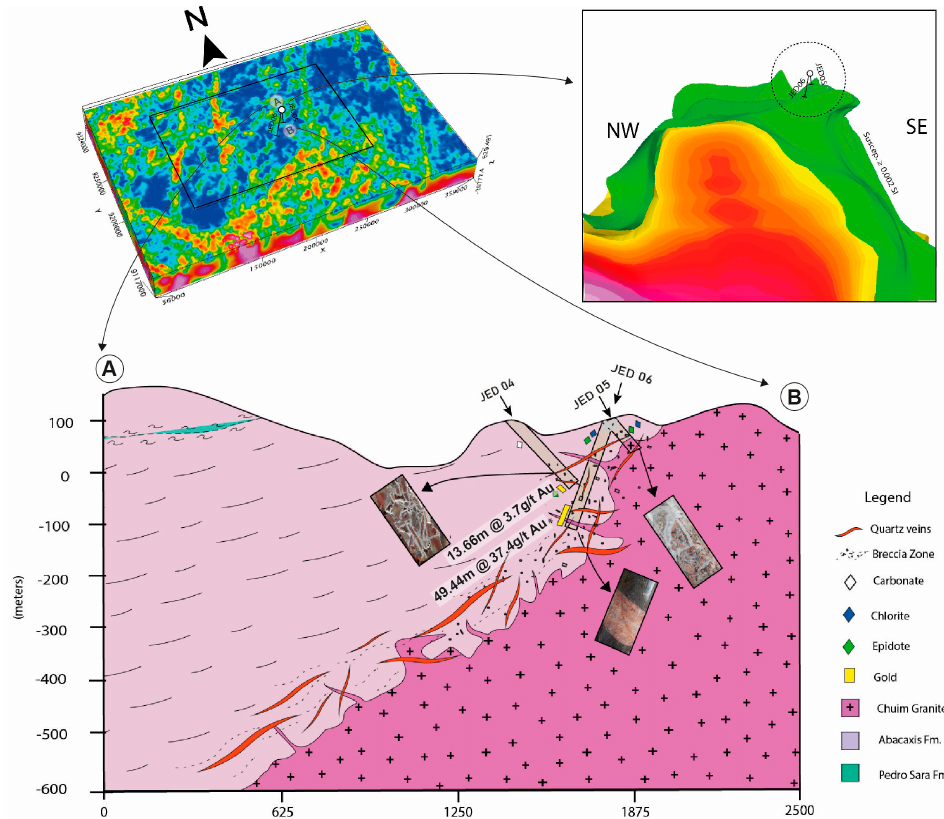
Figure 13. ( A ) Integrated analysis of drill cores (JED–04, JED–05, and JED–06) and the geophysical model for the Guida prospect. ( B ) The isosurface delimited by a 0.002 SI susceptibility was interpreted as the possible contact zone between the Chuim Granite and the volcano-sedimentary sequence. Photographs illustrate intervals from drill cores.